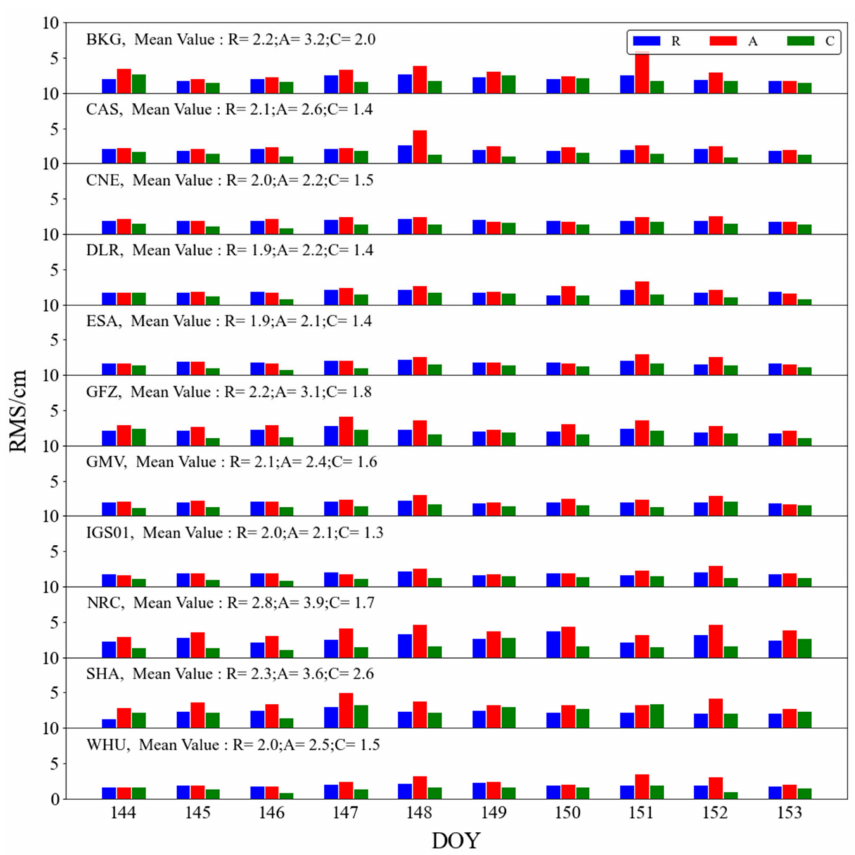
Figure 7. RMS of GRACE-C (GRCC) reduced-dynamic orbit products in the R, A, and C directions from JPL precise orbit ephemeris (POE) (the mean RMS of orbit errors for each AC is shown in each